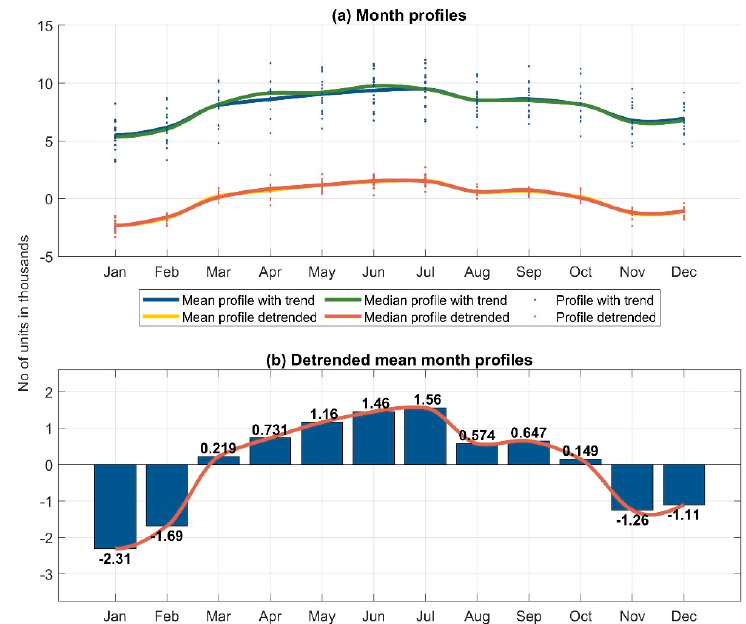
Figure 2. Averaged annual profile. Permits issued for construction—individual (Source: own compilation based on data from CSO).